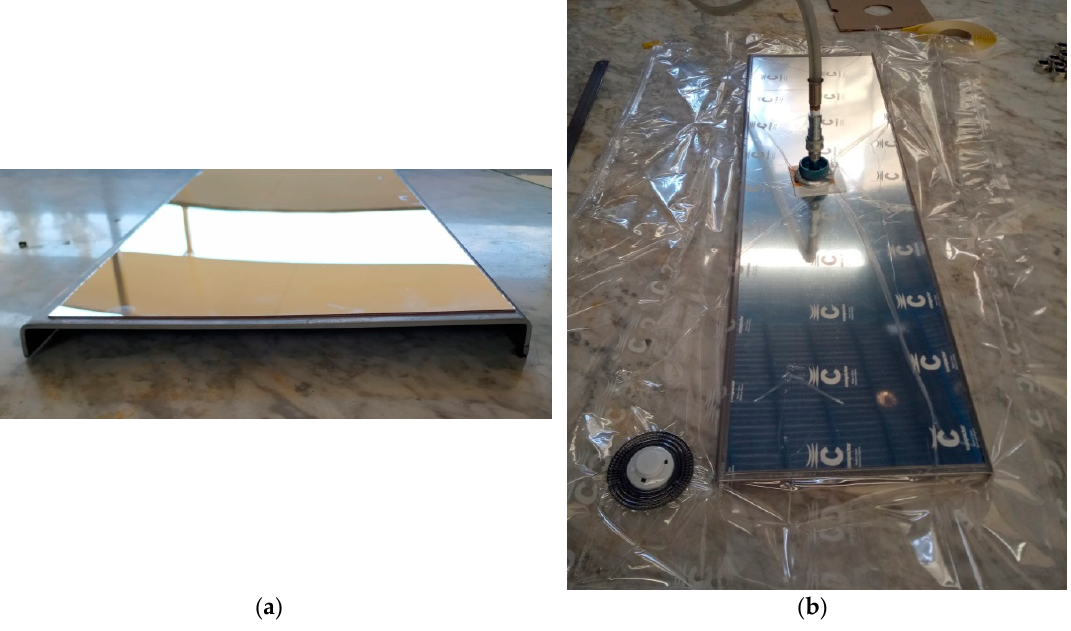
Figure 7. Mirror glued by vacuum to a curved plate: ( a ) pleated mirror facet and ( b ) vacuum gluing process.